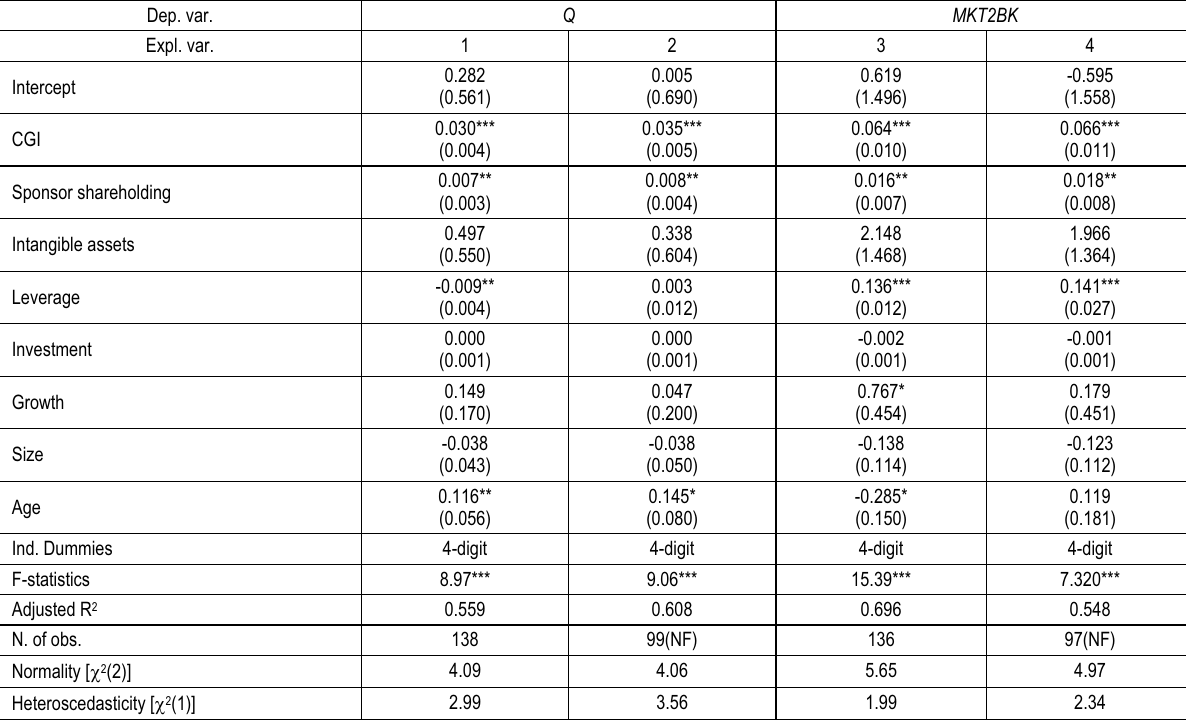
Table 4. OLS regression results of Tobin’s Q and MKT2BK against the corporate governance index (CGI) Dep. var. Q MKT2BK Expl.